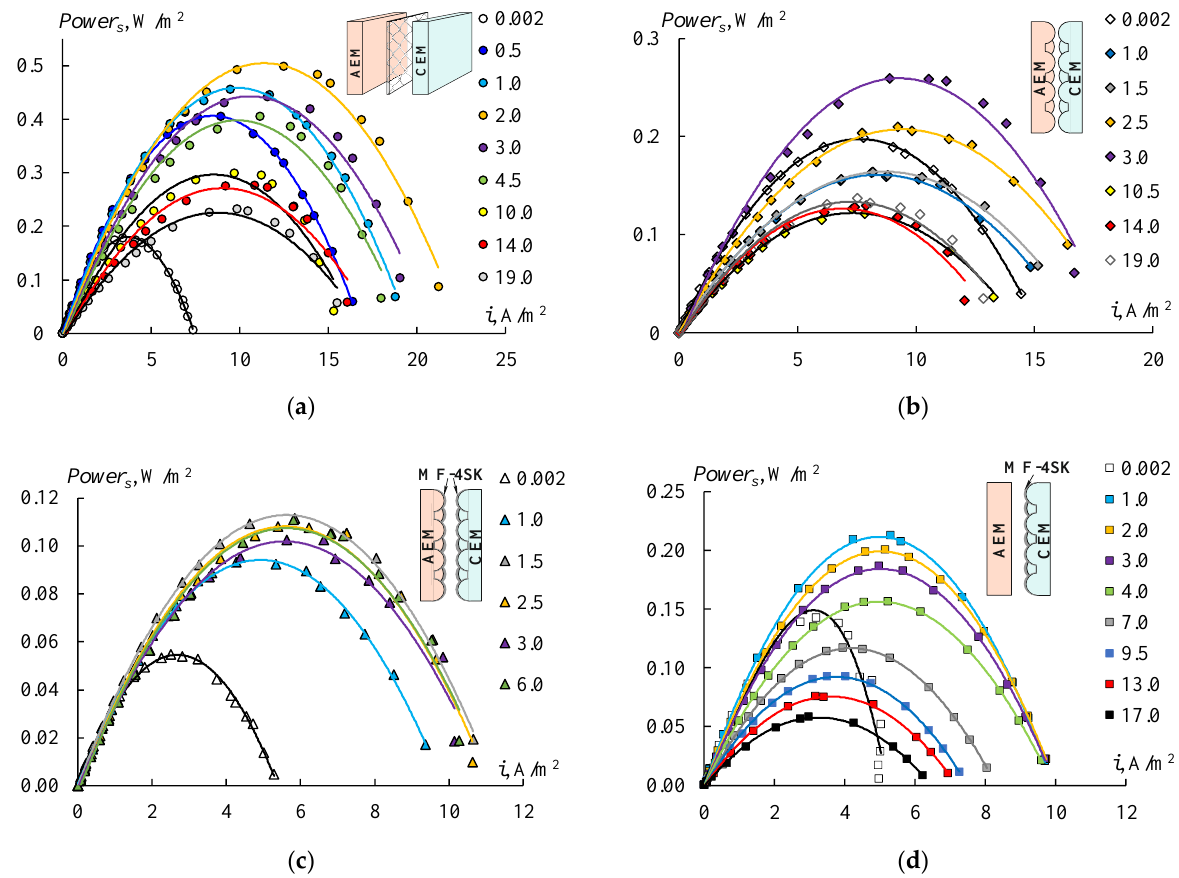
Figure 16. Power density versus current density at different concentrations (g/L) of NaCl in diluted solution for different kinds of membranes into the RED stack: initial smooth MA-41 and MK-40 membranes ( a ), profiled MA-41_3P and MK-40_3P membranes ( b ), profiled bilayer MA-41_3PM and MK-40_3PM membranes ( c ), initial smooth MA-41 and profiled modified MK-40_3PM membranes ( d ). The concentration values are shown in each figure.